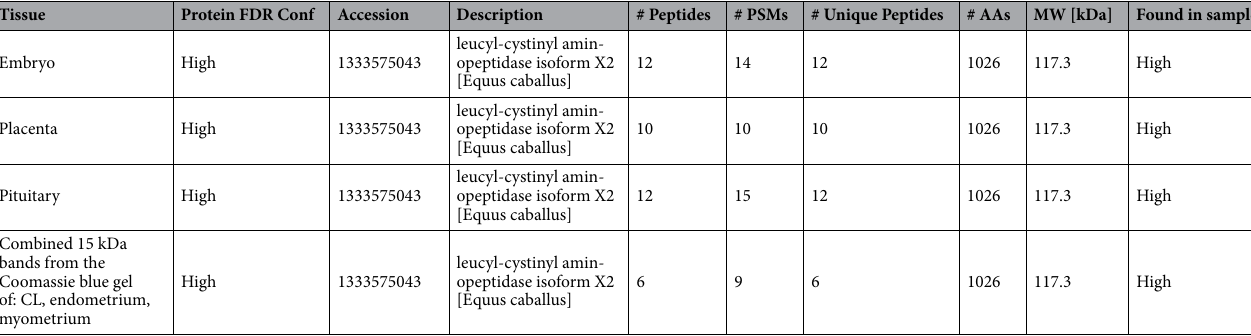
Table 1. Identification of the leucyl-cystinyl aminopeptidase (LNPEP) by the liquid chromatography-tandem mass spectrometry (LC–MS/MS) of the 150 kDa bands of various tissues from the Coomassie blue gel. Protein (#PSMs) = the total number of identified peptide sequences for the protein; # Unique peptide = number of the peptide sequences unique to a protein group; Number of amino acids (#AA) = the sequence length of a